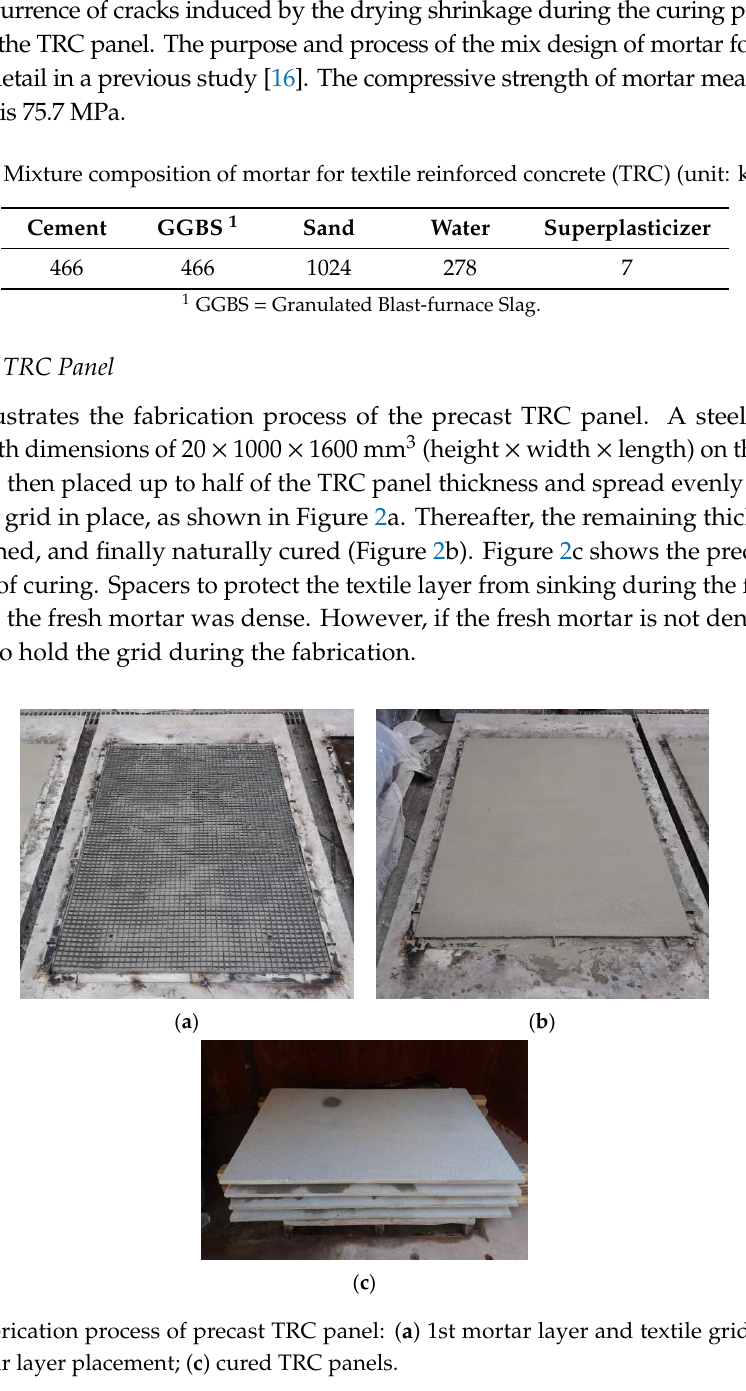
Table 1. Material properties of textile grid in warp direction (suggested by the manufacturer). Fiber